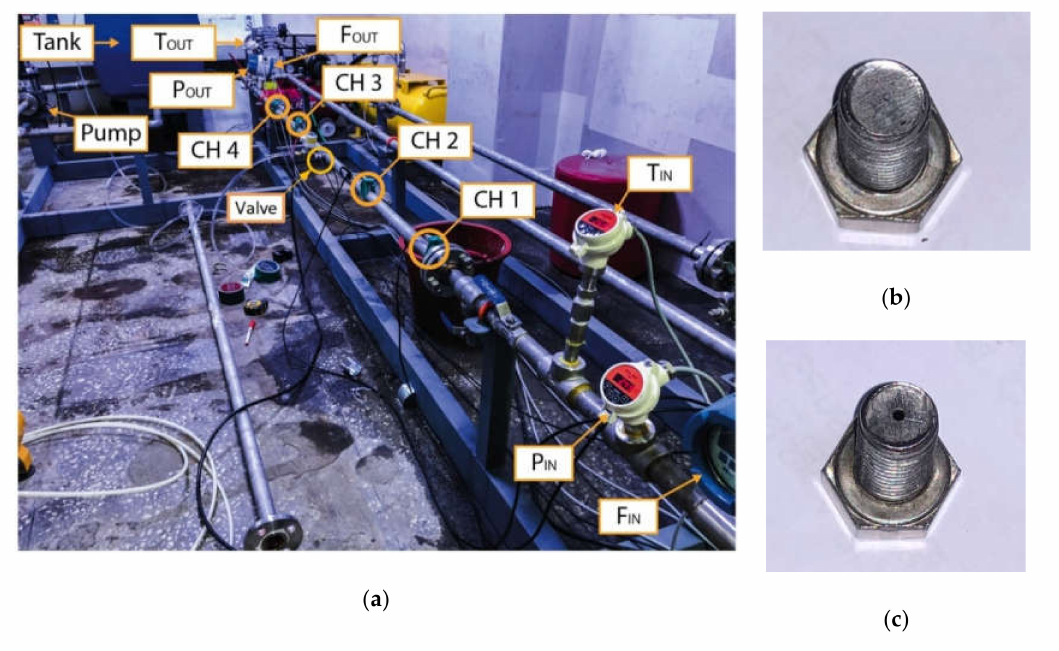
Figure 6. AE signal acquisition from a water pipeline system: ( a ) The test pipeline and component arrangement; ( b ) the pinhole size of 0.3 mm; ( c ) the pinhole size of 2.0 mm. Table 3. Specifications of the wideband di ff erential-auto sensor test (WDI-AST) sensors. No